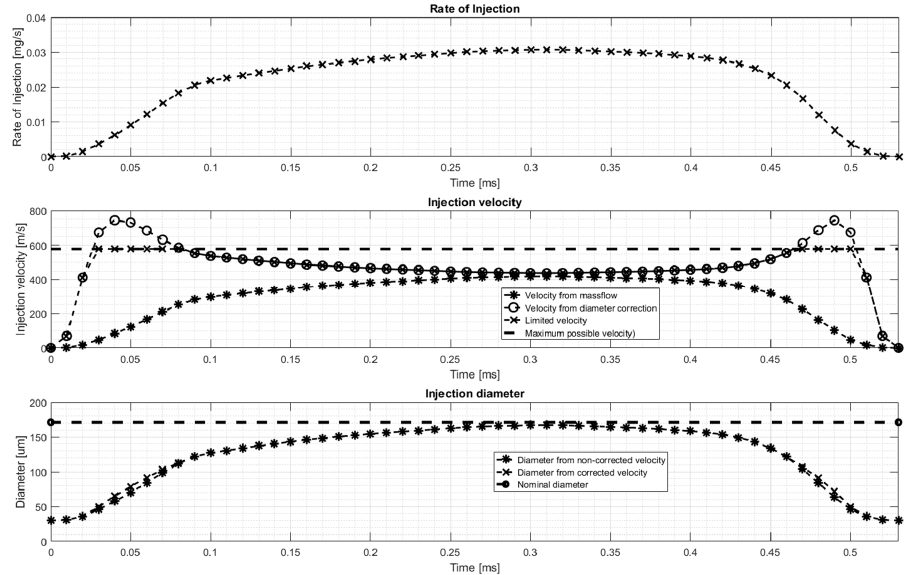
Figure 2. Specification of an inconstant nozzle diameter to modify the injection velocity of the droplets in the simulation model .